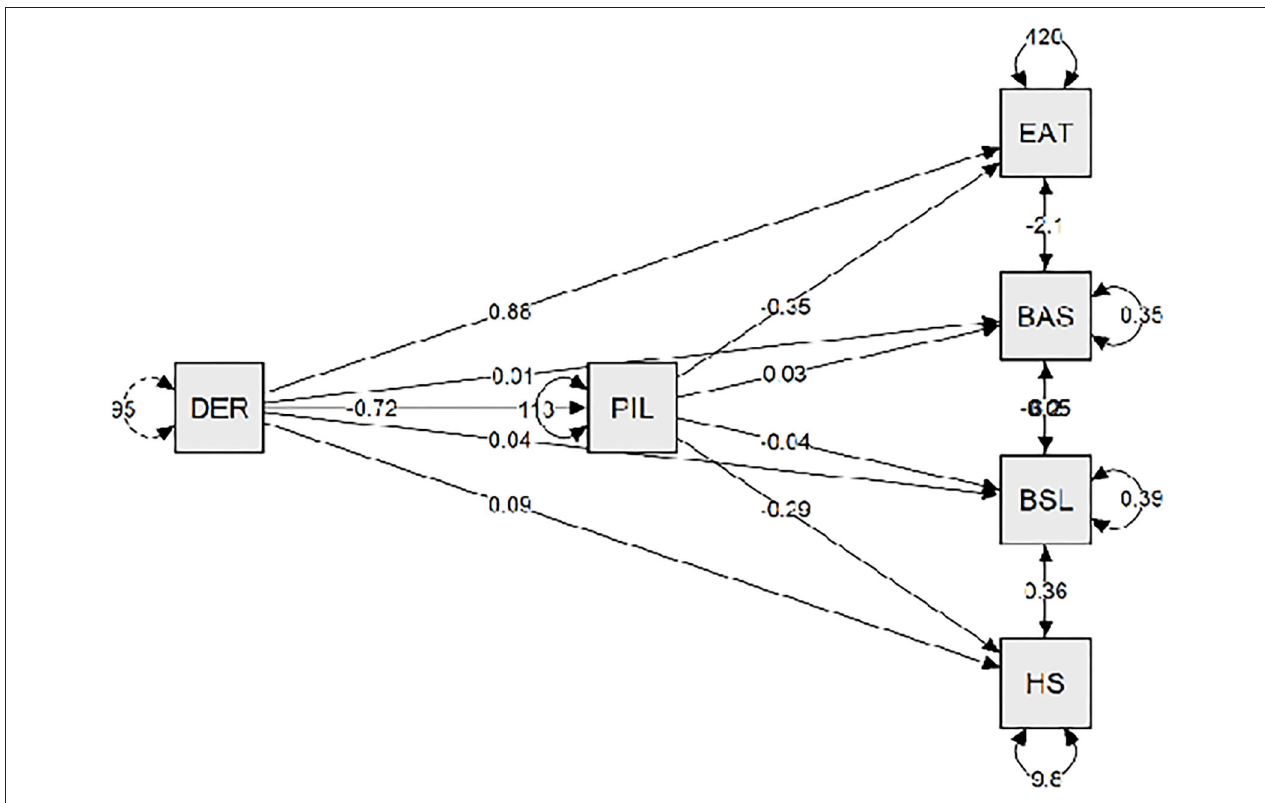
FIGURE 3 | The meaning in life is a mediating variable between the emotional deregulation and the main symptoms of eating disorders. DER, emotional deregulation; PIL, purpose in life; EAT, eating attitude test; BAS, body area satisfaction; BSL, borderline symptom list; HS, hopelessness